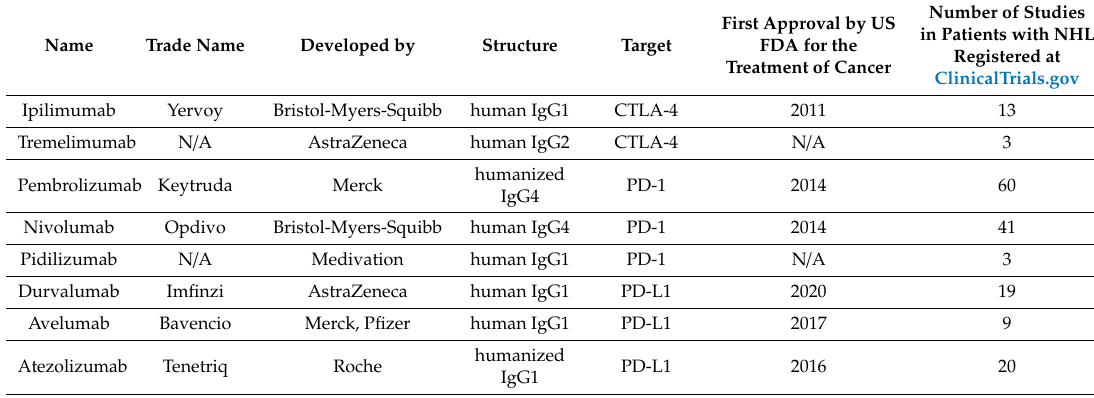
Table 5. Selected checkpoint inhibitors currently being evaluated in patients with